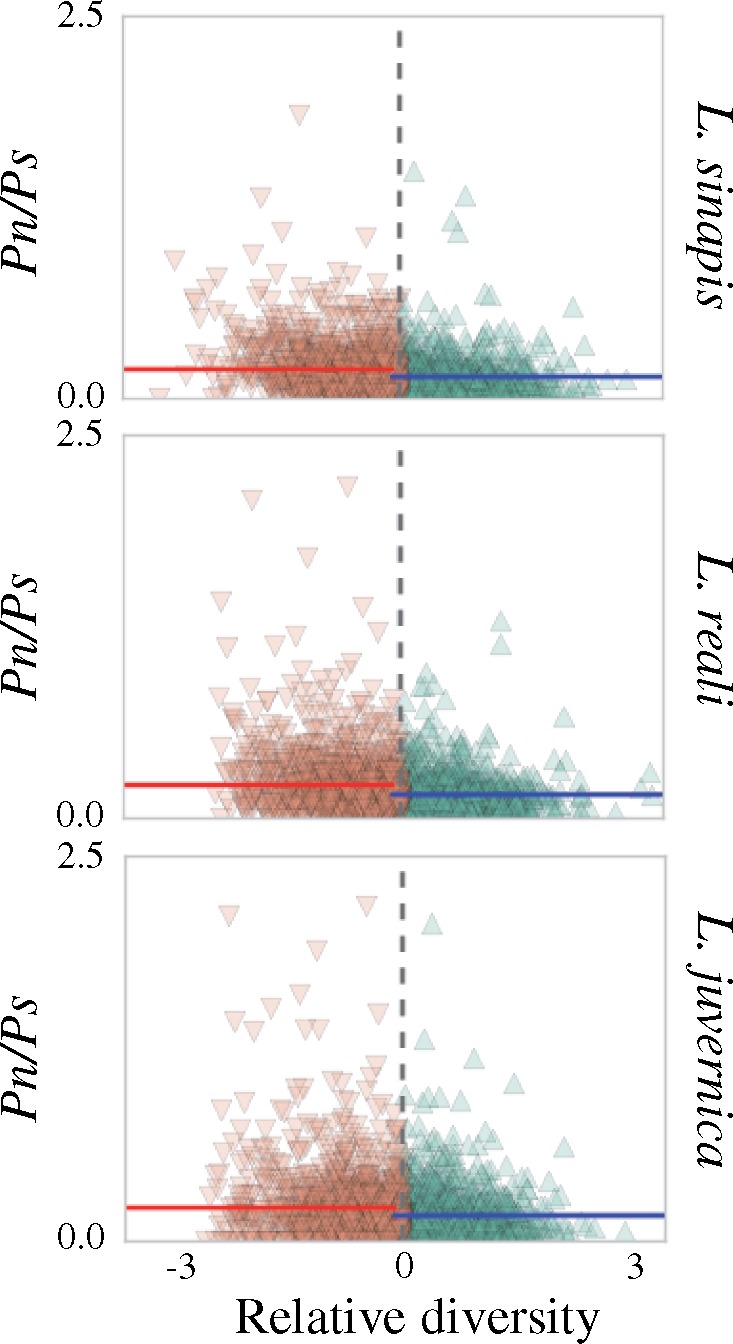
—Scatter plots showing the differences in average pN/pS ratios in low- (brown) and high- (green) diversity regions for each species. Vertical colored lines show the mean pN/pS of low- (red) and high- (blue) diversity regions, respectively. Note that diversity is calculated as the window-based estimate relative to the genomic average (x axis) and data points are therefore centered at 0.